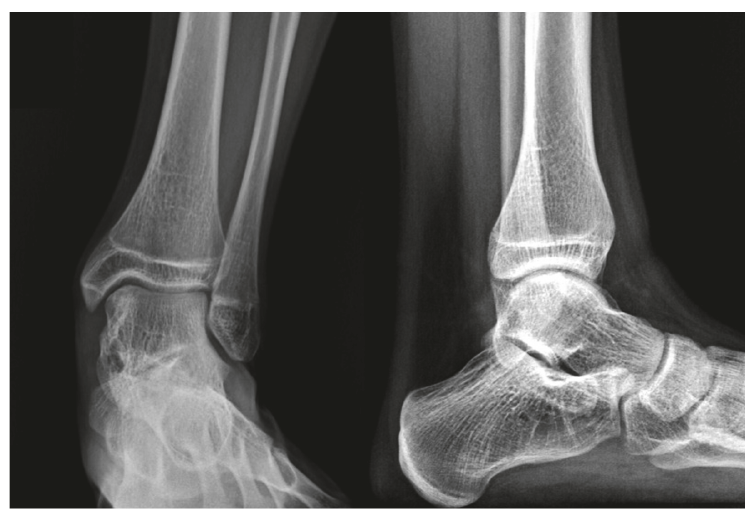
Figure 9: Five-year follow-up X-rays without signs of recurrence or